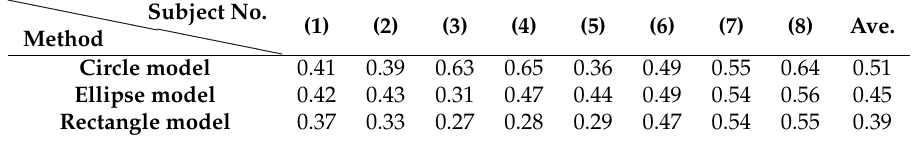
Table 4. The average position error for the three shape-based algorithms w.r.t. the manual measurement.